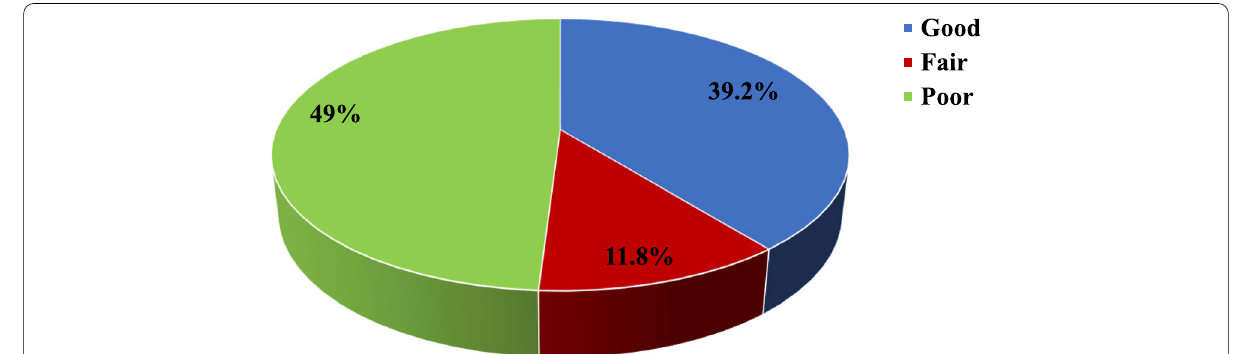
Fig. 2 Overall knowledge score among studied population in Damietta Governorate, Egypt, during COVID-19 pandemic (April 10 to July 15, 2020)